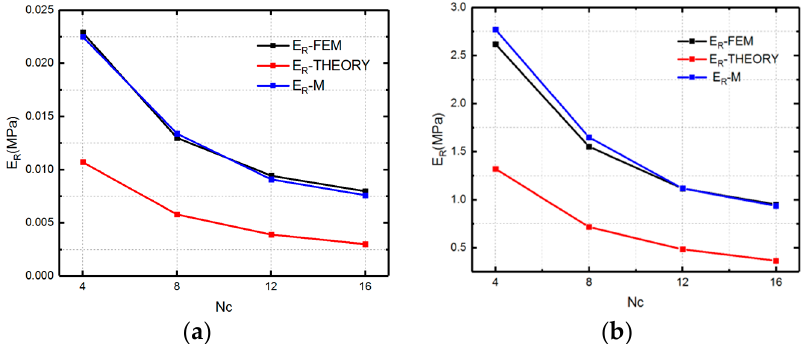
Figure 16. Modulus (El-FEM representing the simulation results of longitudinal modulus of SMP stent, El-THEORY representing the theoretical results of longitudinal modulus of stent and EL-M representing the modified result of longitudinal modulus of stent for Nc = 4) of the SMP stent in the longitudinal direction at two states: ( a ) rubbery state; ( b ) glassy state.